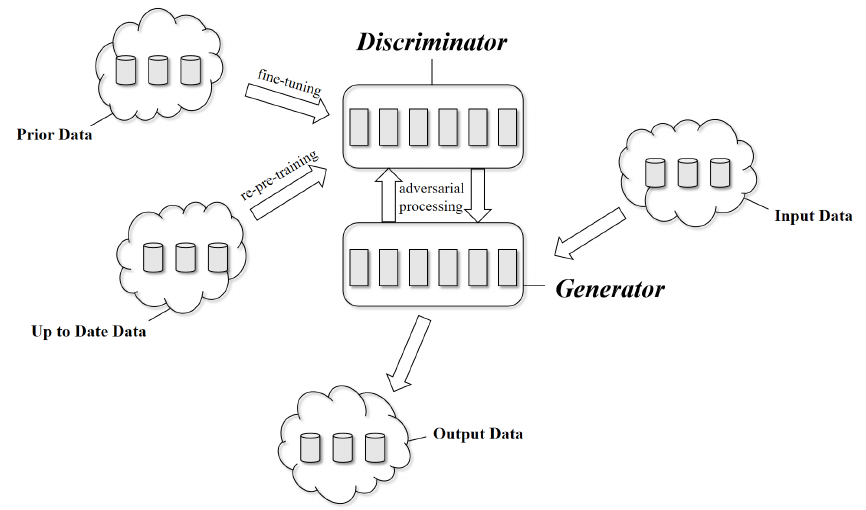
Figure 1. EvoText full